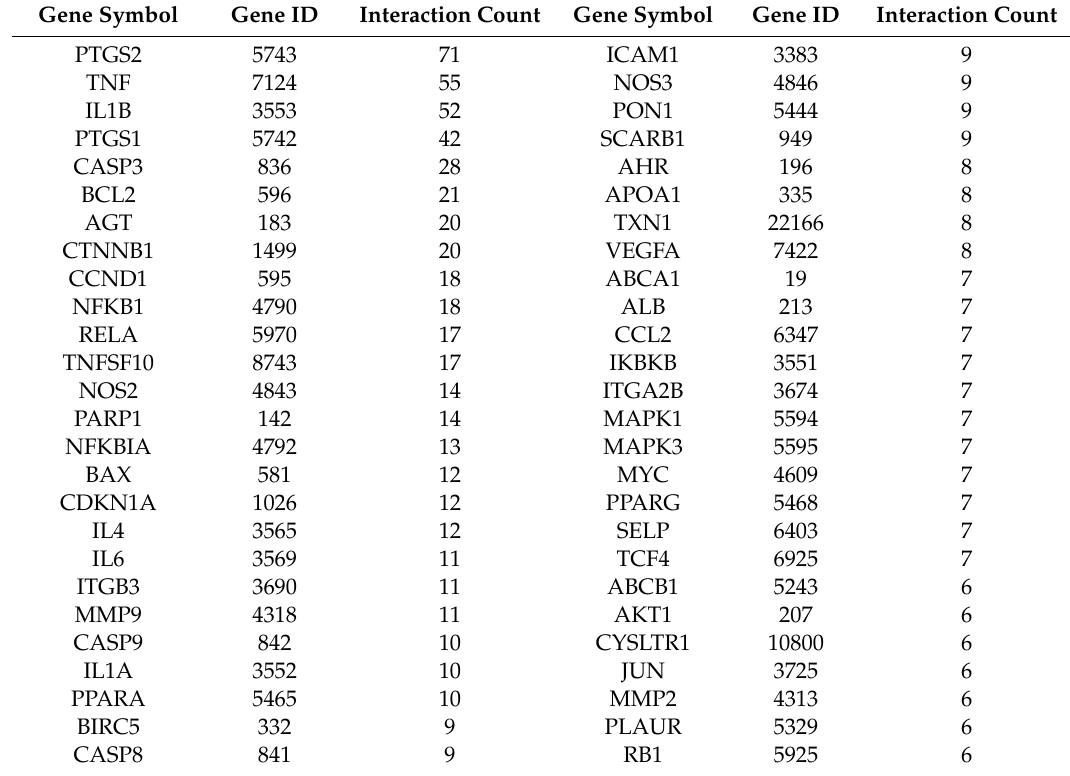
Table 5. Top 52 HCP5 gene interactions associated with Comparative Toxicogenomics Database (CTD)